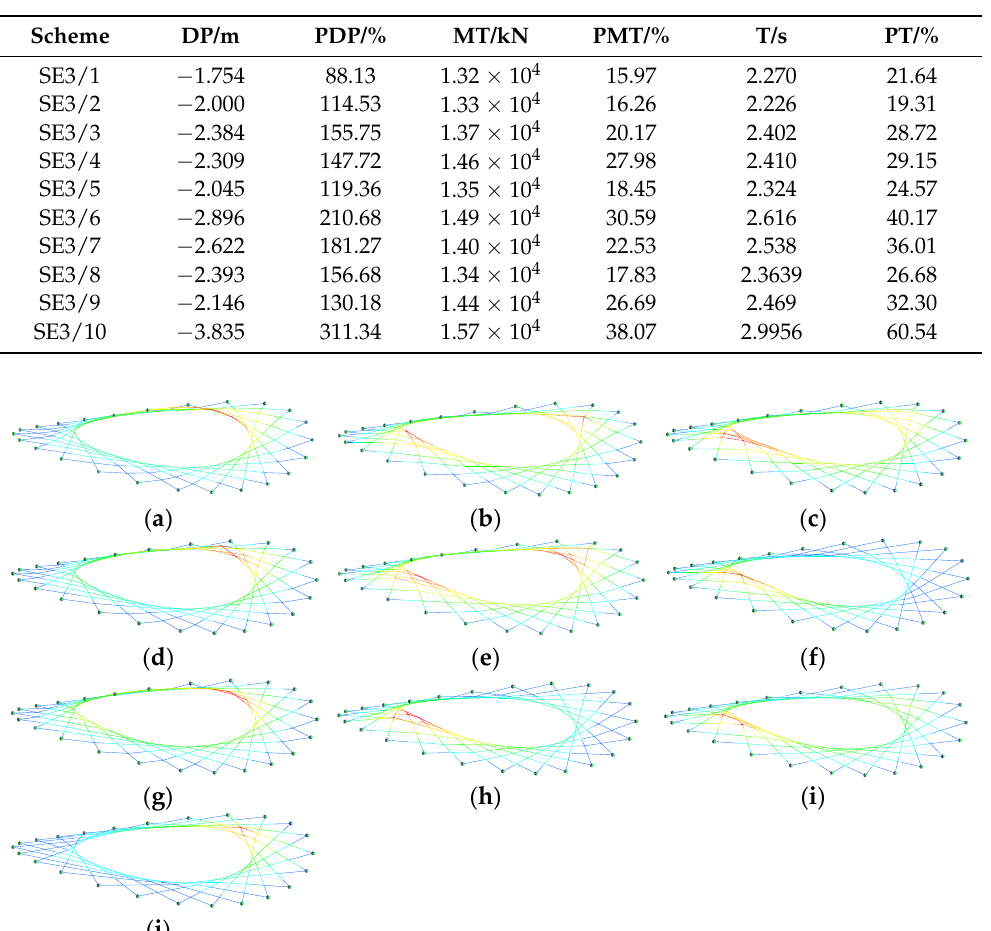
Table 5. Results of deleting three virtual rings.